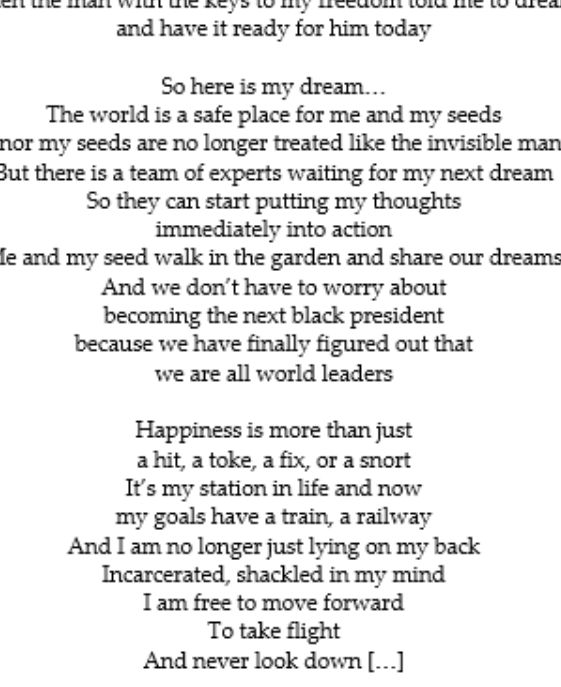
Figure 1. An abridged version of the poem ‘Dream’ by Reggie Daniels, originally published in Brigham and Conner (2018).